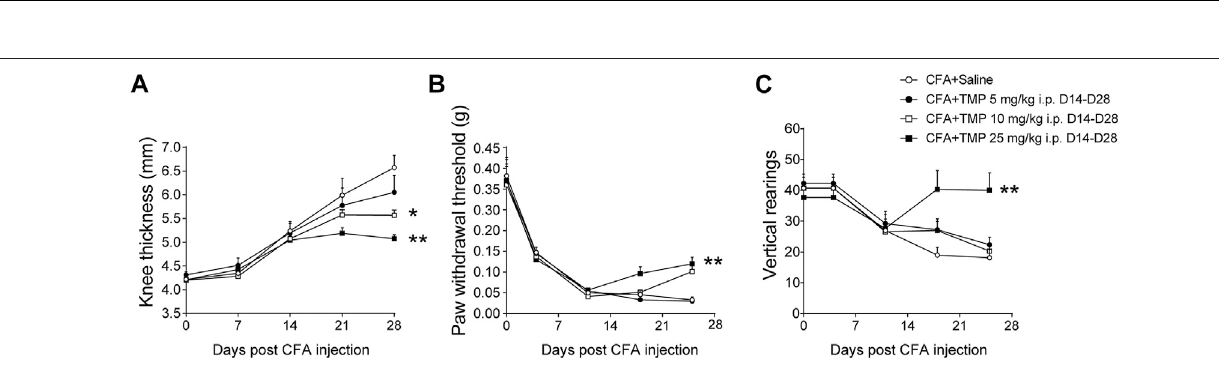
Frontiers in Pharmacology |